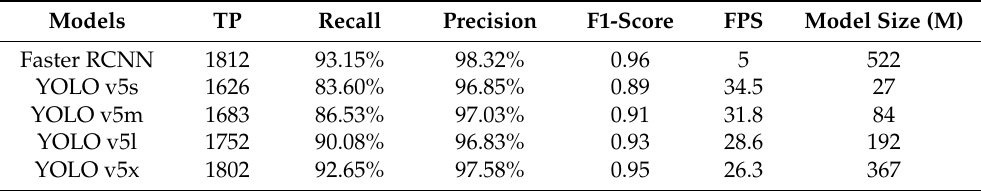
Table 4. Performance indicators for crack detection of various